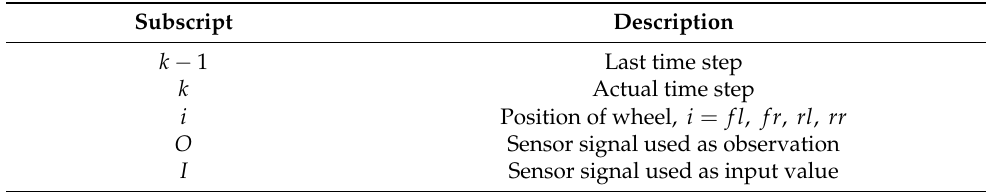
Table A2. Nomenclature for